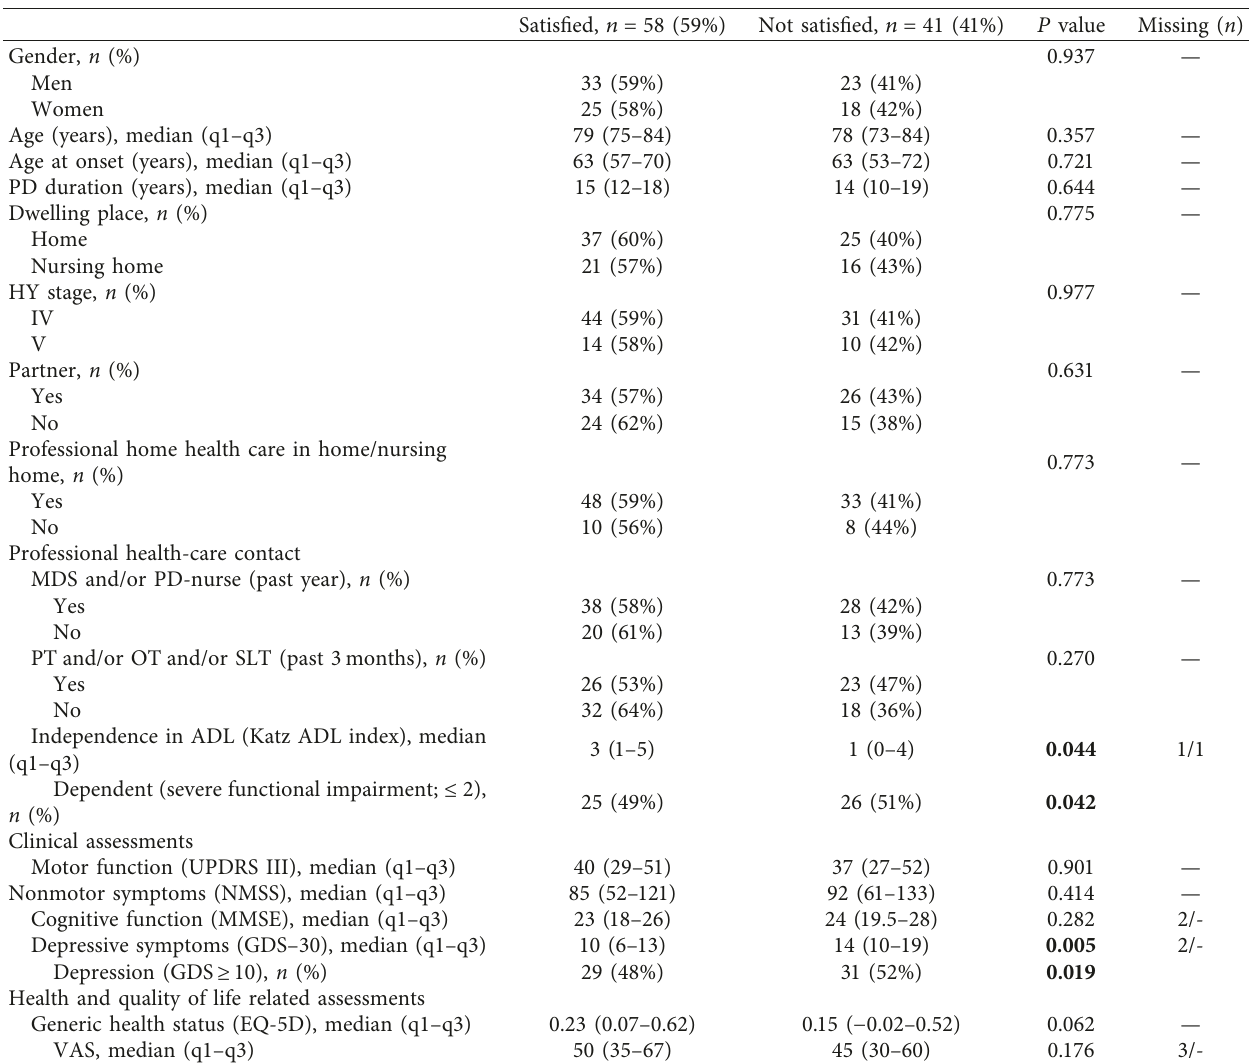
Table 2: Univariate associations with patients’ satisfaction with care ( n �